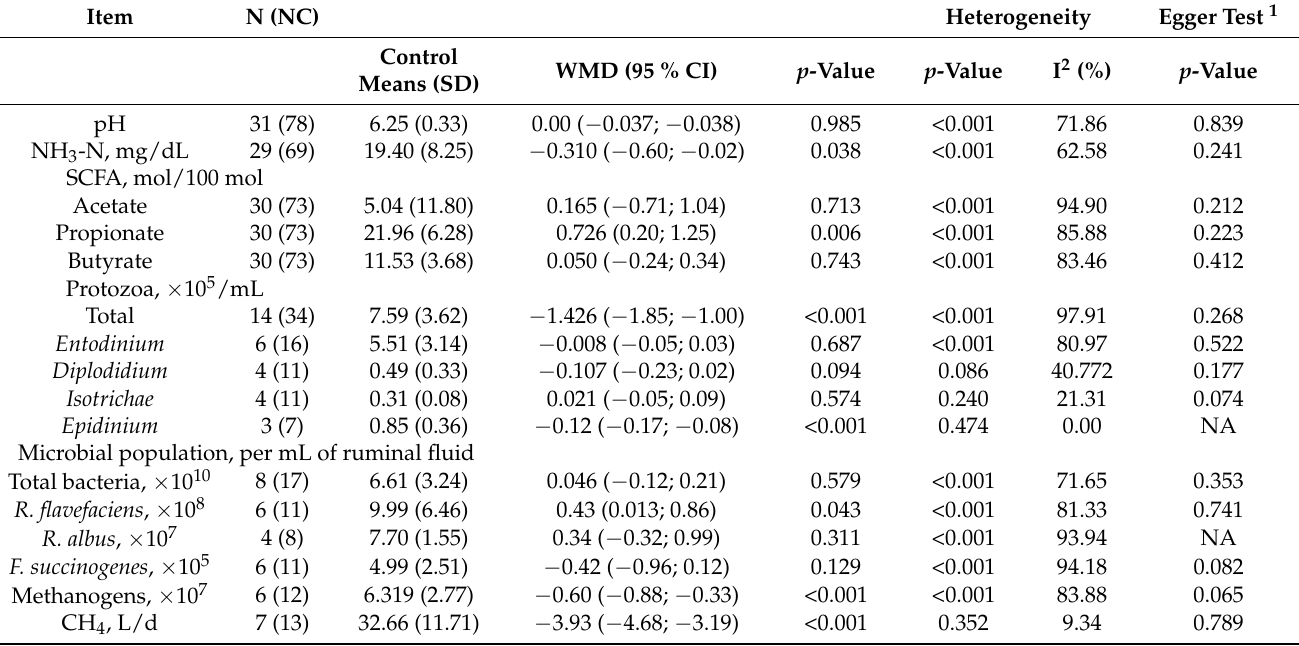
Table 4. Ruminal fermentation and ruminal microorganisms of small ruminants supplemented with essential oils.